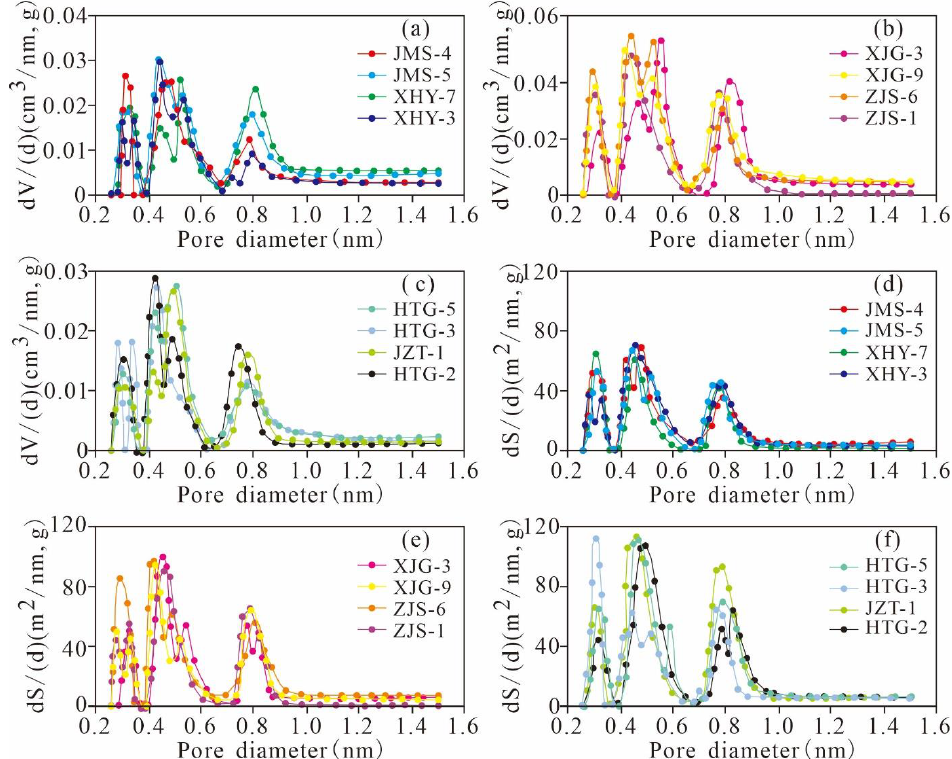
Figure 6. Micropore PV ( a – c ) and SA ( d – f ) distribution derived from the CO 2 adsorption isotherms of the Mesoproterozoic Xiamaling shale in Zhangjiakou, Hebei.